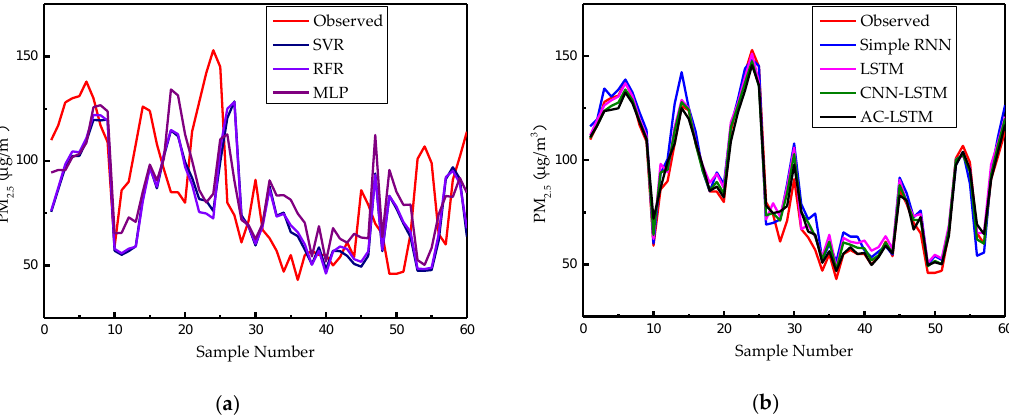
Figure A2. The results of all models in the 5-h PM 2.5 prediction: ( a ) SVR, RFR, and MLP; ( b ) simple RNN, LSTM, CNN–LSTM, and AC-LSTM.